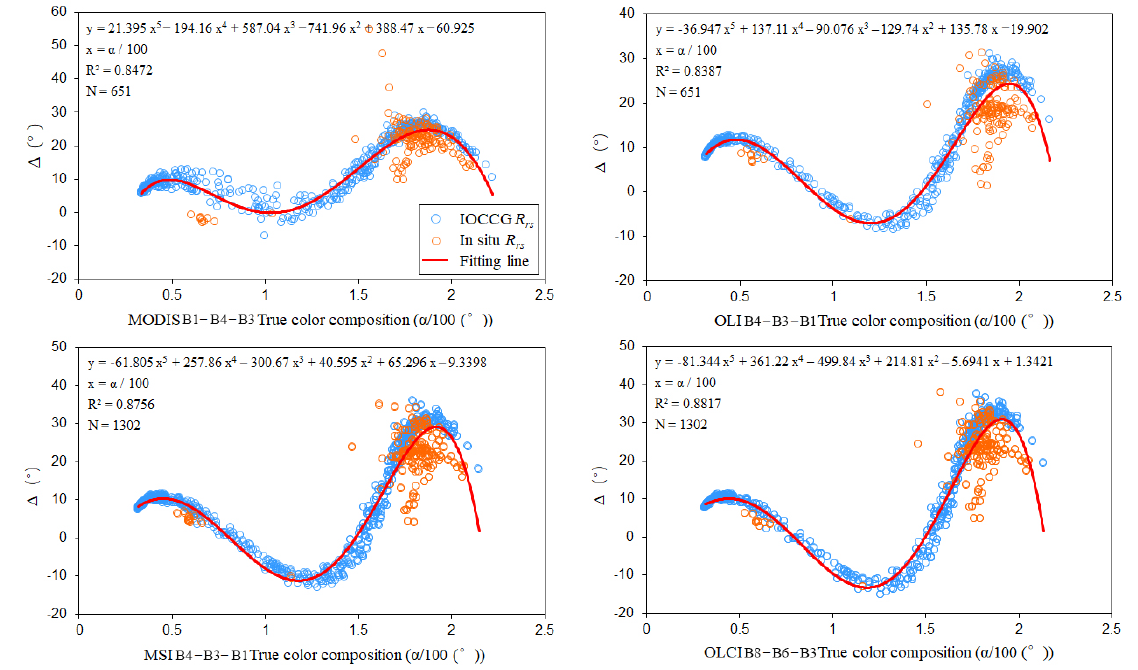
Figure 6. Deviation delta ∆ ( ◦ ) from the hyperspectral hue angle as a function of satellite image hue angle derived from the linear satellite band combination.